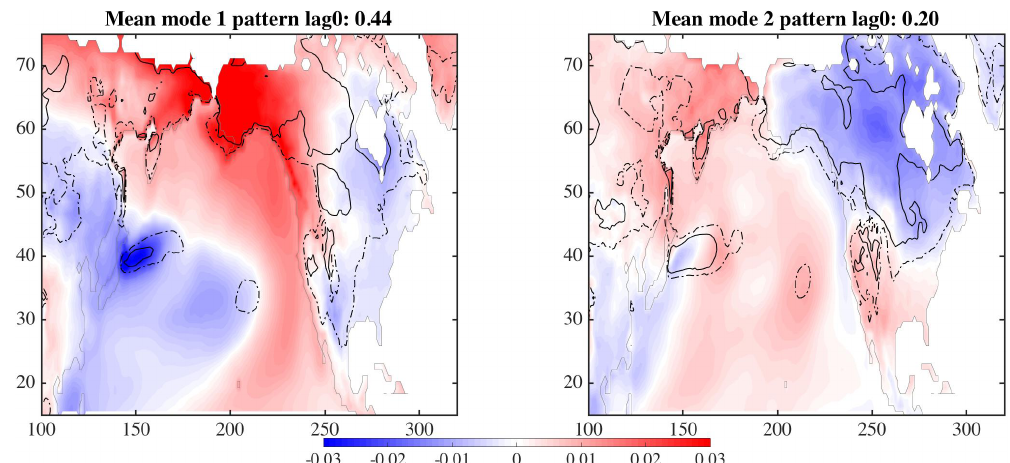
Figure 6. Mean of North Pacific MCA maps in Fig. 5 shown by shading. Contours represent relative variance of the maps in Fig. 5. Contours are for 0.0004 and 0.0008. The number in the title represents the average percent covariance explained by all 30 maps in Fig.